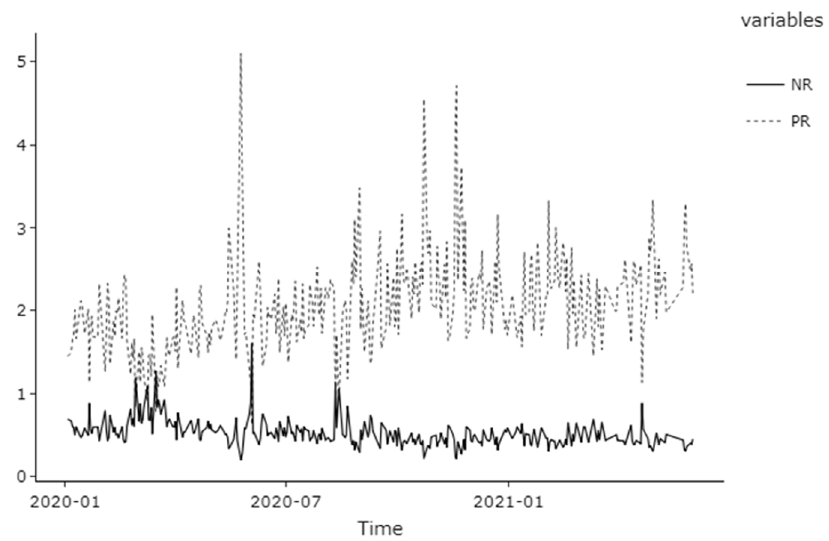
Figure 2. Time-varying investor sentiment indicators.